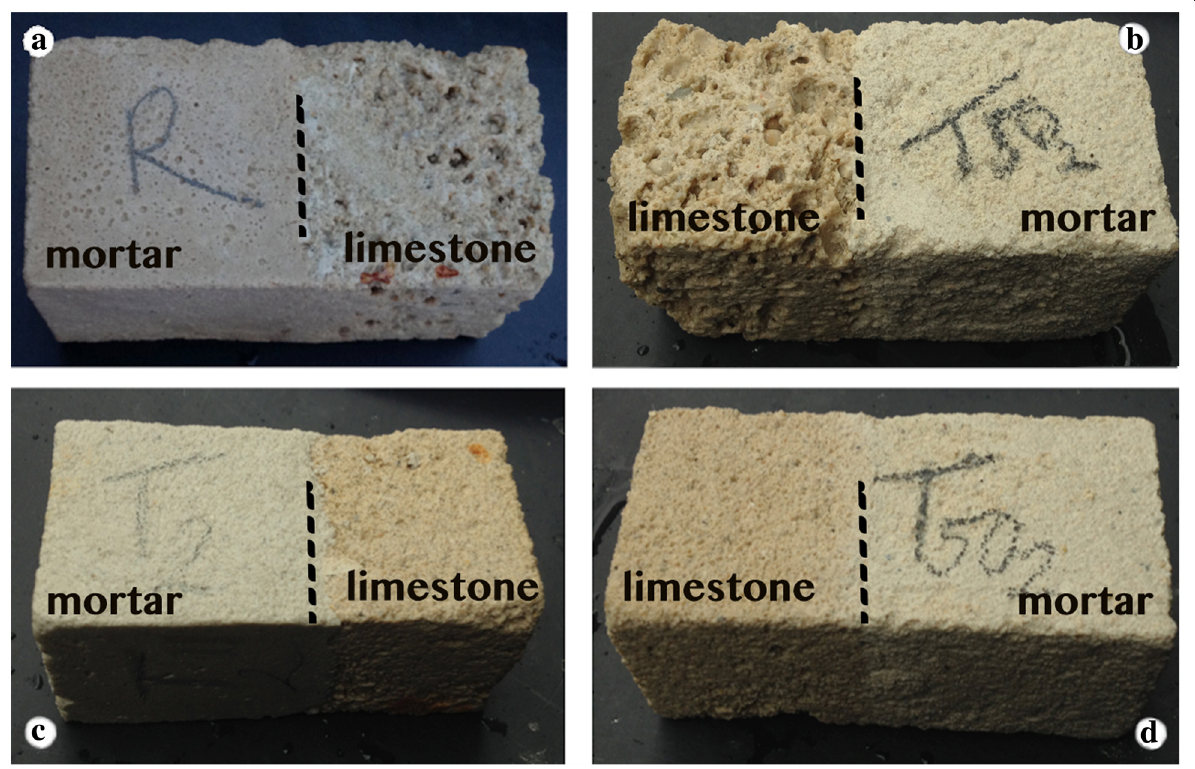
Fig. 1 Samples of repair mortars/limestone prisms (dashed lines represent the boundaries). a Coarse-grained limestone and repair mortar R. b Coarse-grained limestone and repair mortar T50. c Fine-grained limestone and repair mortar T. d Fine-grained limestone and repair mortar